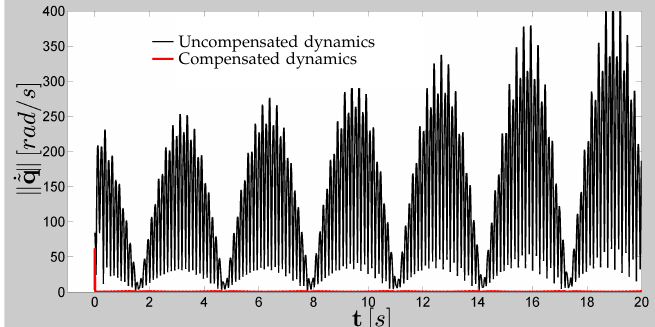
Figure 9. The speed error for the tracking task.